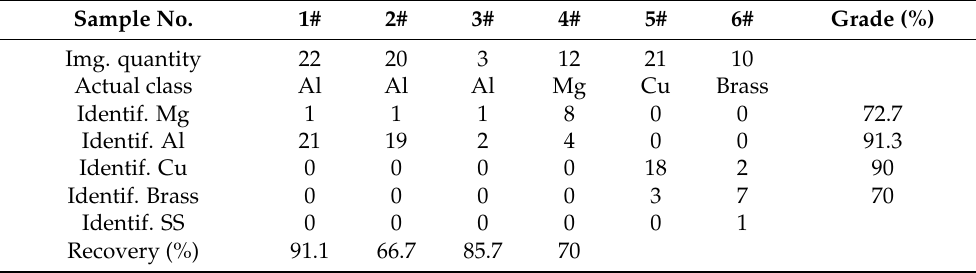
Table 5. Identification results of different self-made materials.